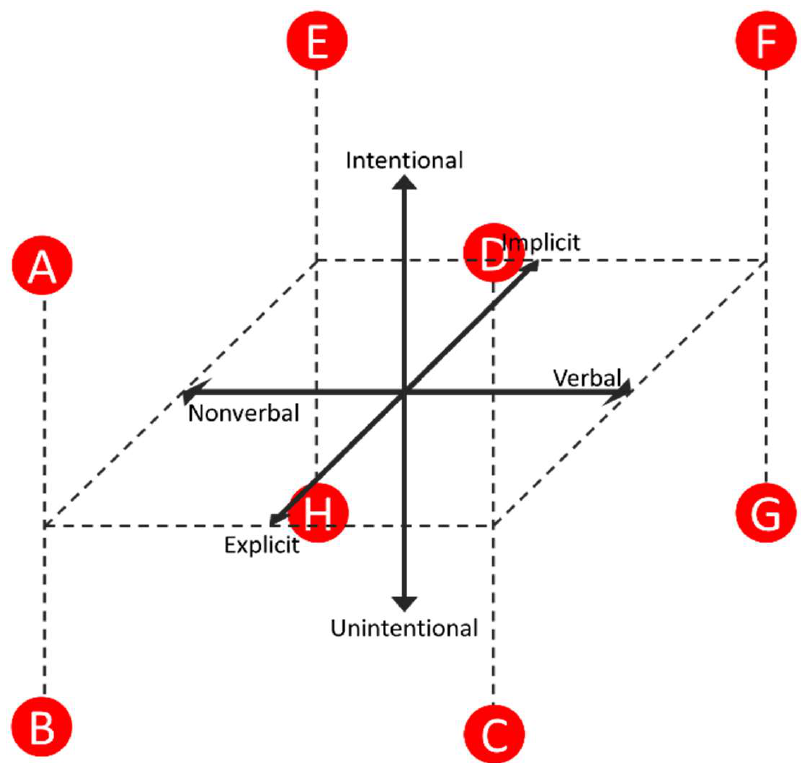
Figure 2. Communication can be classified along the three dimensions of verbal–nonverbal, implicit–explicit, and intentional–unintentional. Head nods during an interaction are an example of nonverbal, explicit, and unintentional communication ( A ). “Freudian slips” fall in the unintentional, verbal and explicit quadrant ( C ). An instruction such as “bring me a glass of water” are verbal-explicit- intentional ( D ). Irony is an example of communication that combines verbal-implicit-intentional ( F ) with